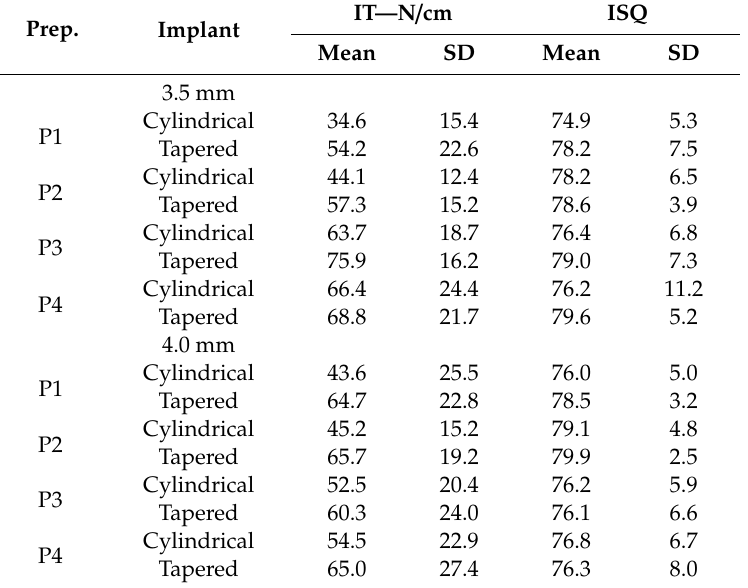
Table 1. Values of the Insertion Torque (IT, Newton / cm) and Implant Stability Quotient (ISQ) results for the di ff erent types of preparation technique for 3.5 mm and 4.0 mm diameter in both implant designs. IT—N / cm ISQ Prep. Implant